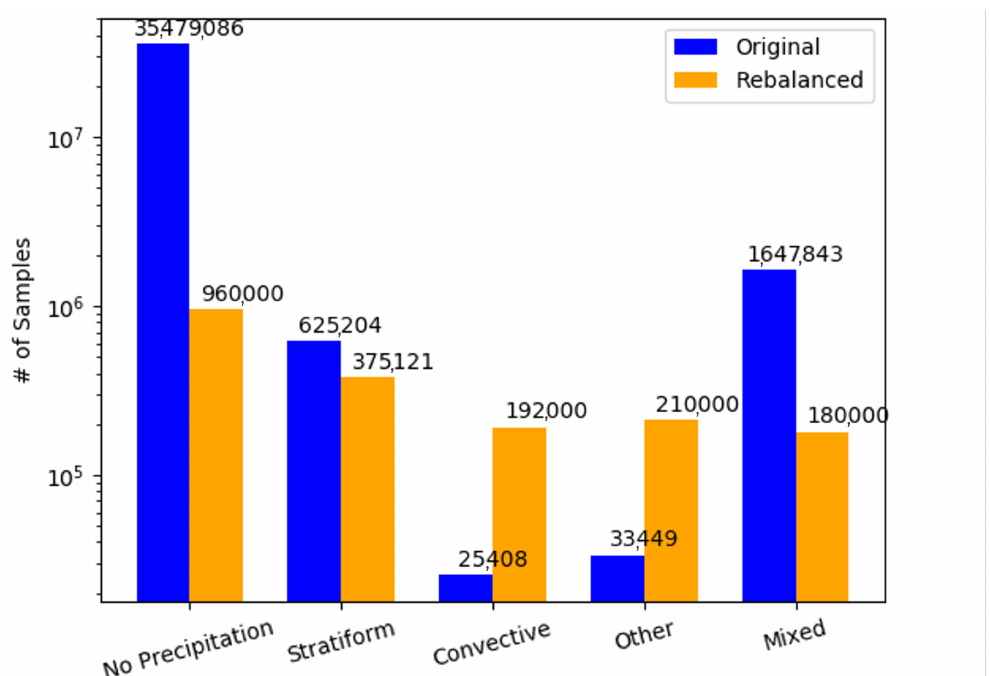
Figure 3. Number of samples under each precipitation type from the training dataset from the original (blue) and after rebalancing (orange) for the entire training